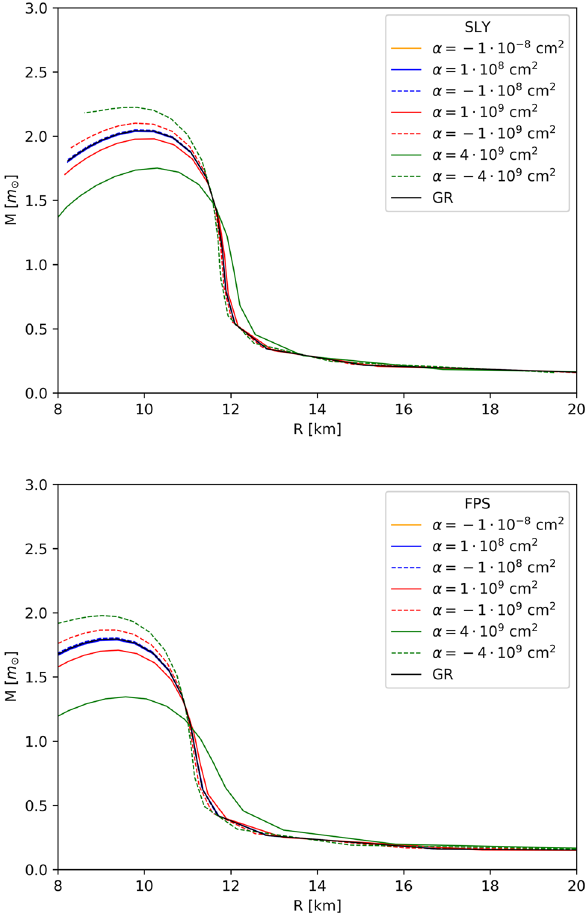
Fig. 2 Mass-radius relation for GR and f ( R ) = R + α R 2 , the SLy and FPS EoS and different values of the parameter